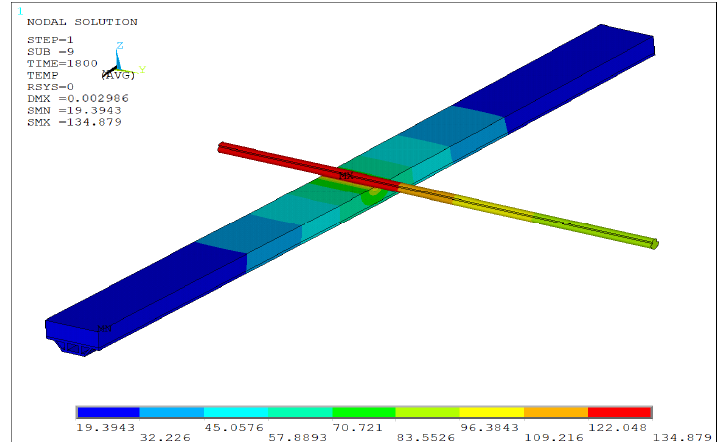
Figure 7. Temperature distribution in the system: sliding strip–contact wire for a BIII strip material with a value of k = 15 W/(m × K) and c = 900 W/(kg × K).